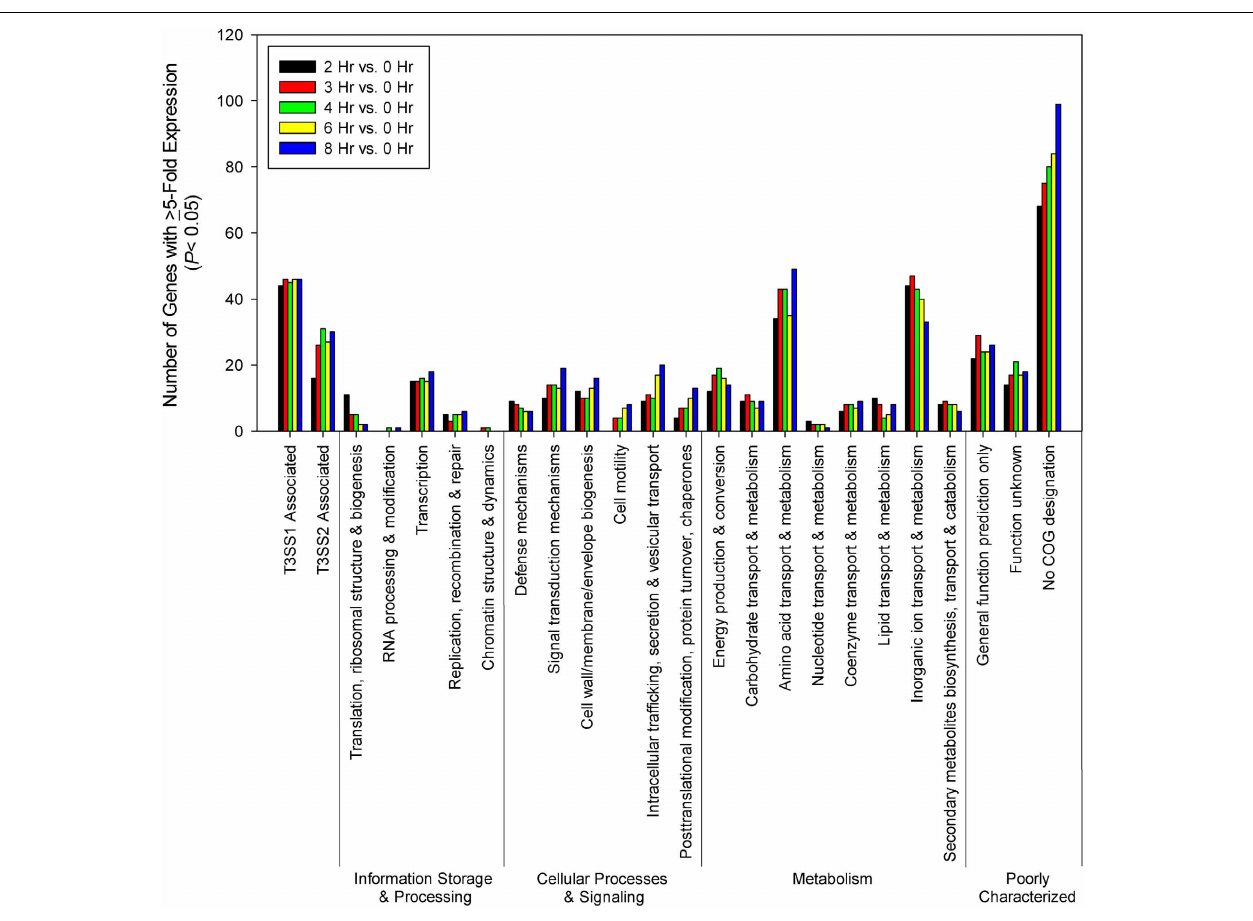
Clustered Regularly Interspaced Short Palindromic Repeats (CRISPR) associated proteins in several different